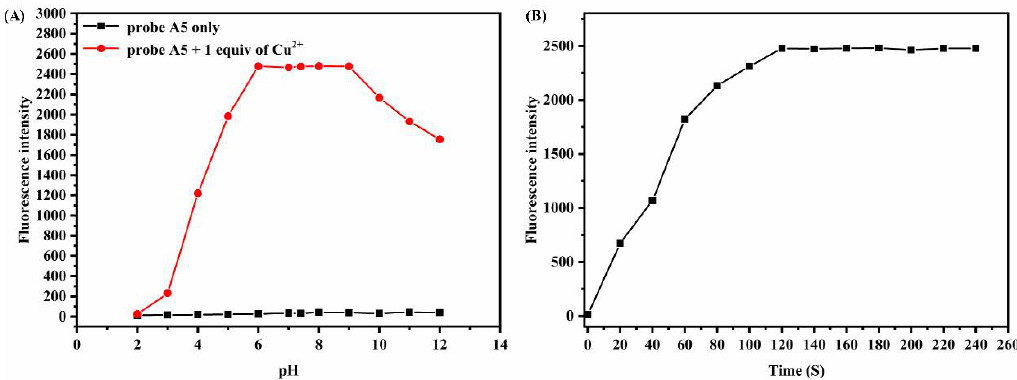
Figure 1. ( A ) Fluorescence intensity (525 nm) of A5 probe (20.0 μM) and the mixture at different pH levels. ( B ) Fluorescence intensity (525 nm) after adding Cu 2+ (20.0 μM) to A5 (20.0 μM) at different times in PBS buffer (10 mM, pH = 7.4)/EtOH (1:1, v / v ), λex = 440 nm.